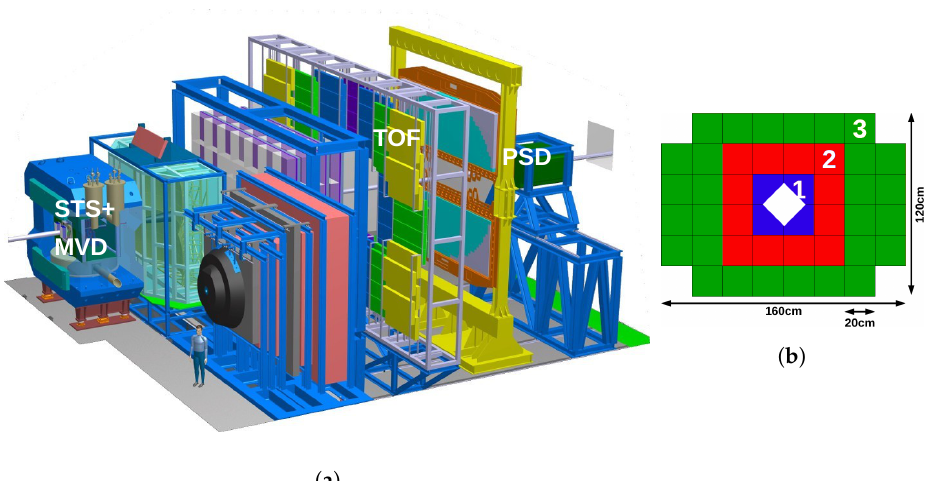
Figure 1. ( a ) The layout of the CBM experiment. ( b ) The layout of the PSD modules in the plane transverse to the beam direction. Colors show module groups (subevents) used for the projectile spectator symmetry plane angle Ψ p estimation: PSD1 (central), PSD2 (middle) and PSD3 SP